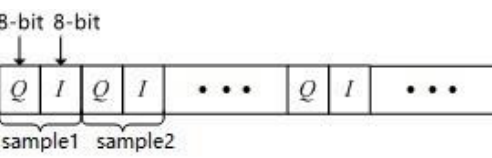
Figure 5. Schematic diagram of the data storage format.